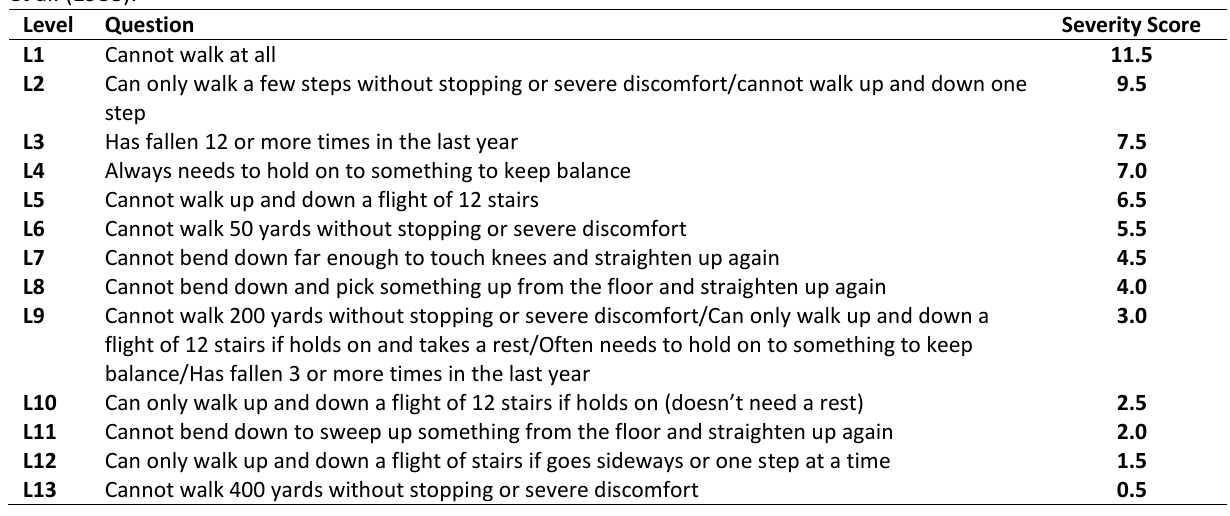
Table 2. Different levels of locomotion ability and respective severity scores. Sources: Grundy et al. (1999) and Martin et al. (1988).